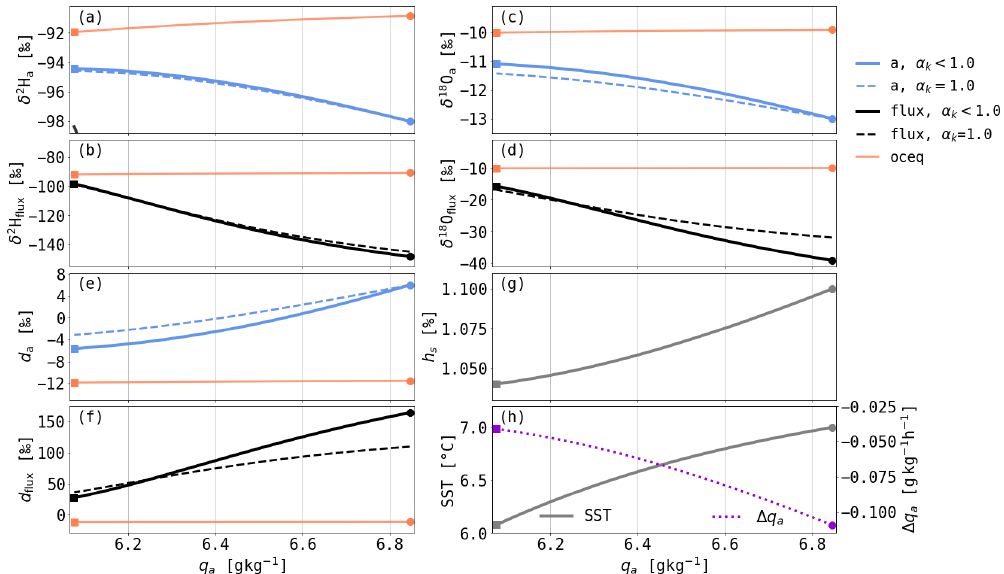
Figure 4. Evolution of (a, b) δ 2 H, (c, d) δ 18 O and (e, f) d as a function of the air parcel’s specific humidity q a in an example simulation with APM dew (see text for details). The blue line shows the isotopic composition of the water vapour in the air parcel (a), the orange line shows that of the equilibrium vapour with the ocean surface (oceq) and the black line shows that of the dew deposition flux (flux). The simulation is shown with non-equilibrium fractionation ( α k < 1 . 0, solid lines in panels a – f ) and without ( α k = 1 . 0, dashed lines in panels a – f ). Furthermore, the evolution of (g) h s and (h) the SST (grey solid line) and (cid:49)q a (purple dashed line) during the simulations is shown. The values of (cid:49)q a are calculated assuming that the SST decrease of 0.9 ◦ C occurred over 12h. Notice that the simulations start to the right (dots) and end to the left (squares) as the air parcel loses moisture during dew